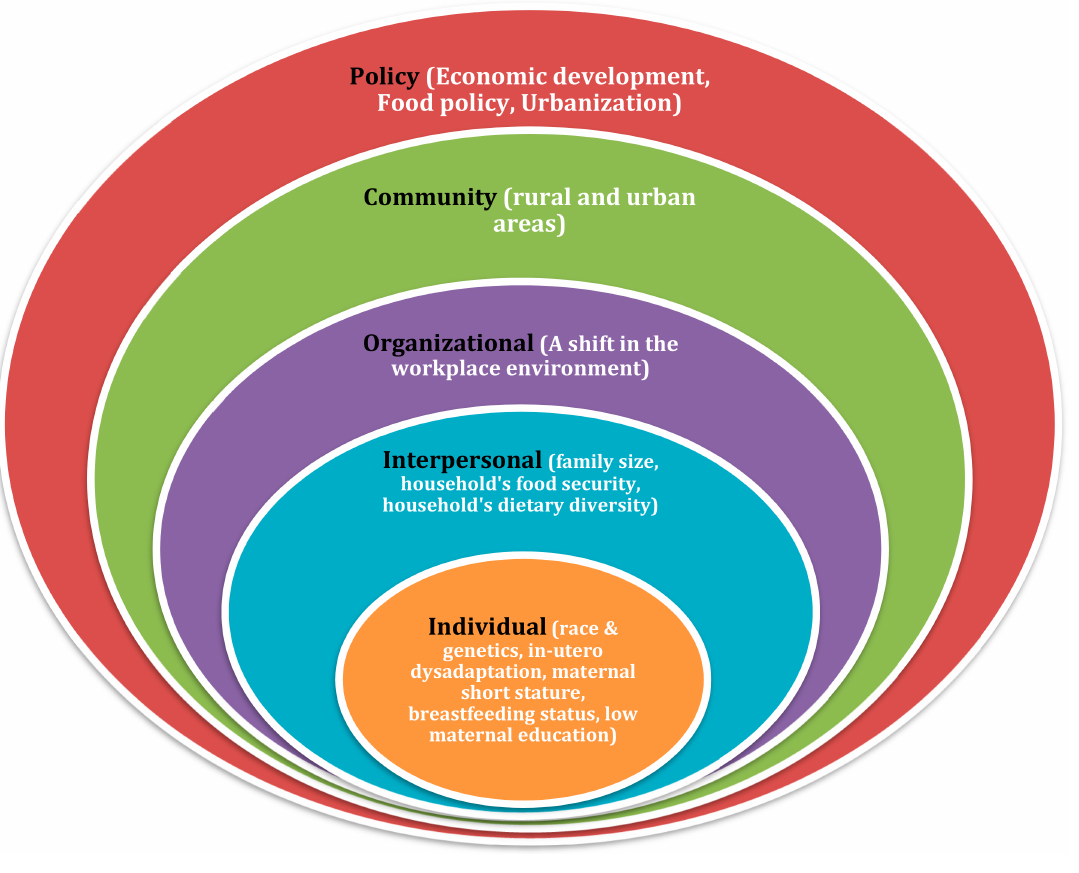
Figure A1. Socio-ecological model of correlates of double burden of